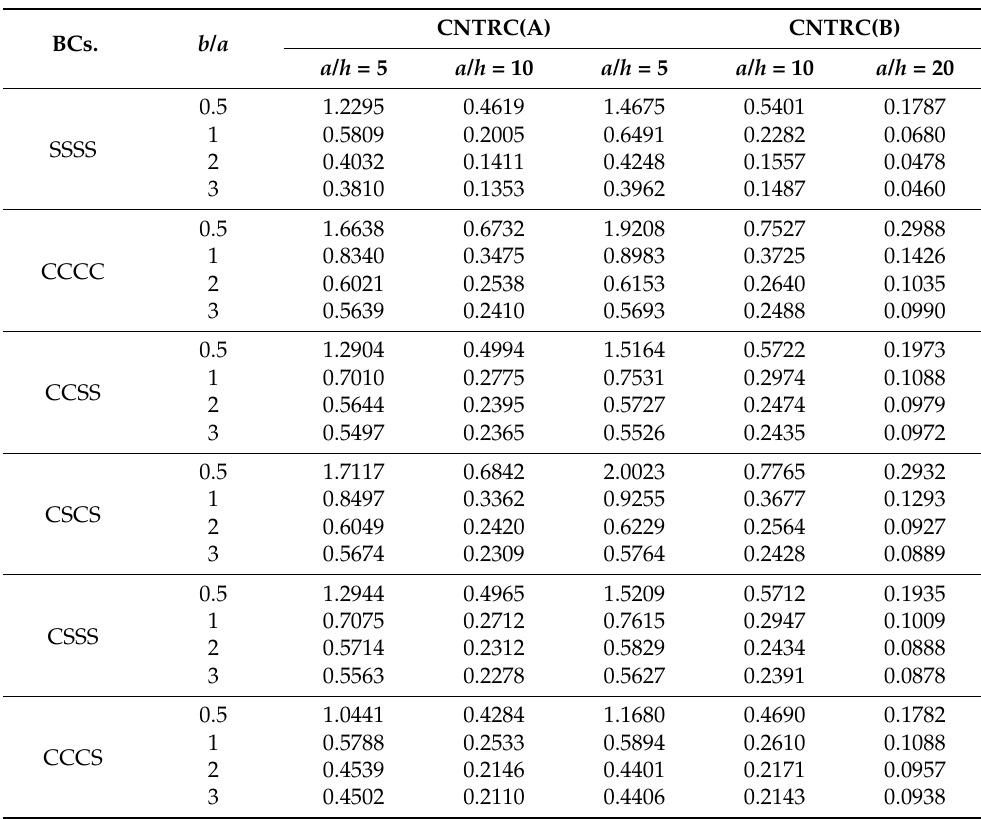
Table 6. Effect of geometric parameters a / h and b / a on the dimensionless frequency of spherical CNTRC shells for various boundary conditions ( p = 1, N = 10, b / a = 1, a / h = 10, V cnt = 0.17, T = 300 K ).